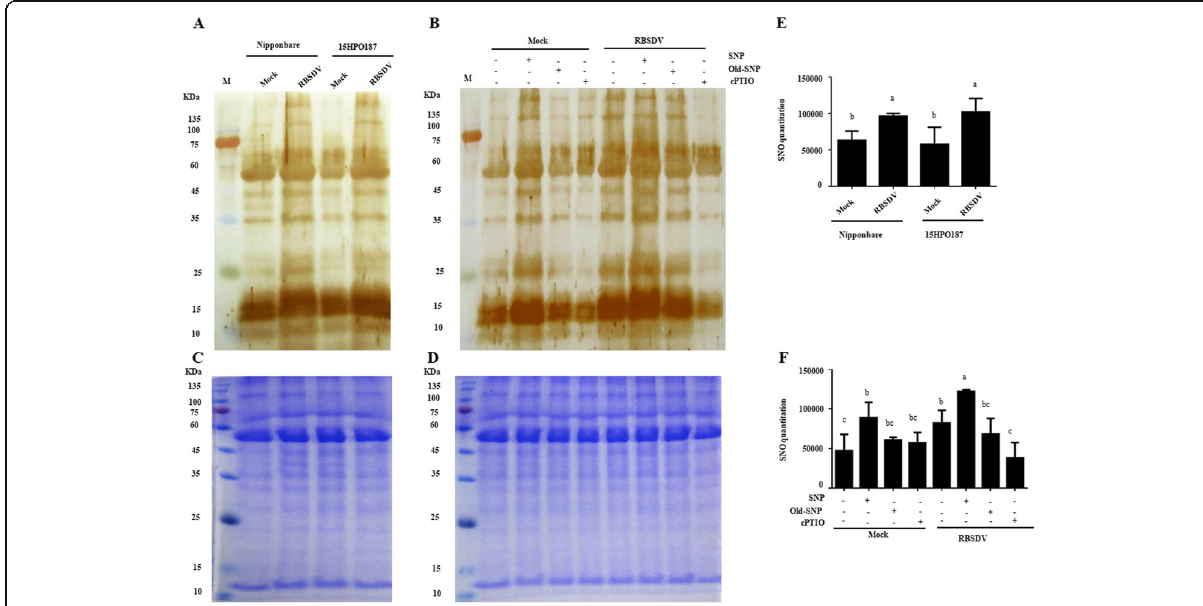
Fig. 5 NO-dependent protein S -nitrosylation. a Total protein was isolated from the mock- or RBSDV-inoculated Nipponbare or 15HPO187 plants. The isolated protein samples were analyzed by a modified biotin switch method followed by western blot assay using a biotin specific antibody. Lanes with darker labeling signal indicate stronger protein S -nitrosylation. b Total protein was isolated from the SNP-, old SNP- or cPTIO-treated and mock- or RBSDV-inoculated plants and analyzed as described in ( a ). Numbers on the left slide of the gels are the size of protein markers. c and d Images of gels stained with Coomassie Brilliant Blue, and used to show equal protein loadings. Images are representative of experiments repeated at least three separate times. The blot was quantified using ImageJ software (http://rsbweb.nih.gov/ij/). The data represented the means ± SD of the three replicates. M, protein marker. All the experiment were repeated 3 times and representative results are